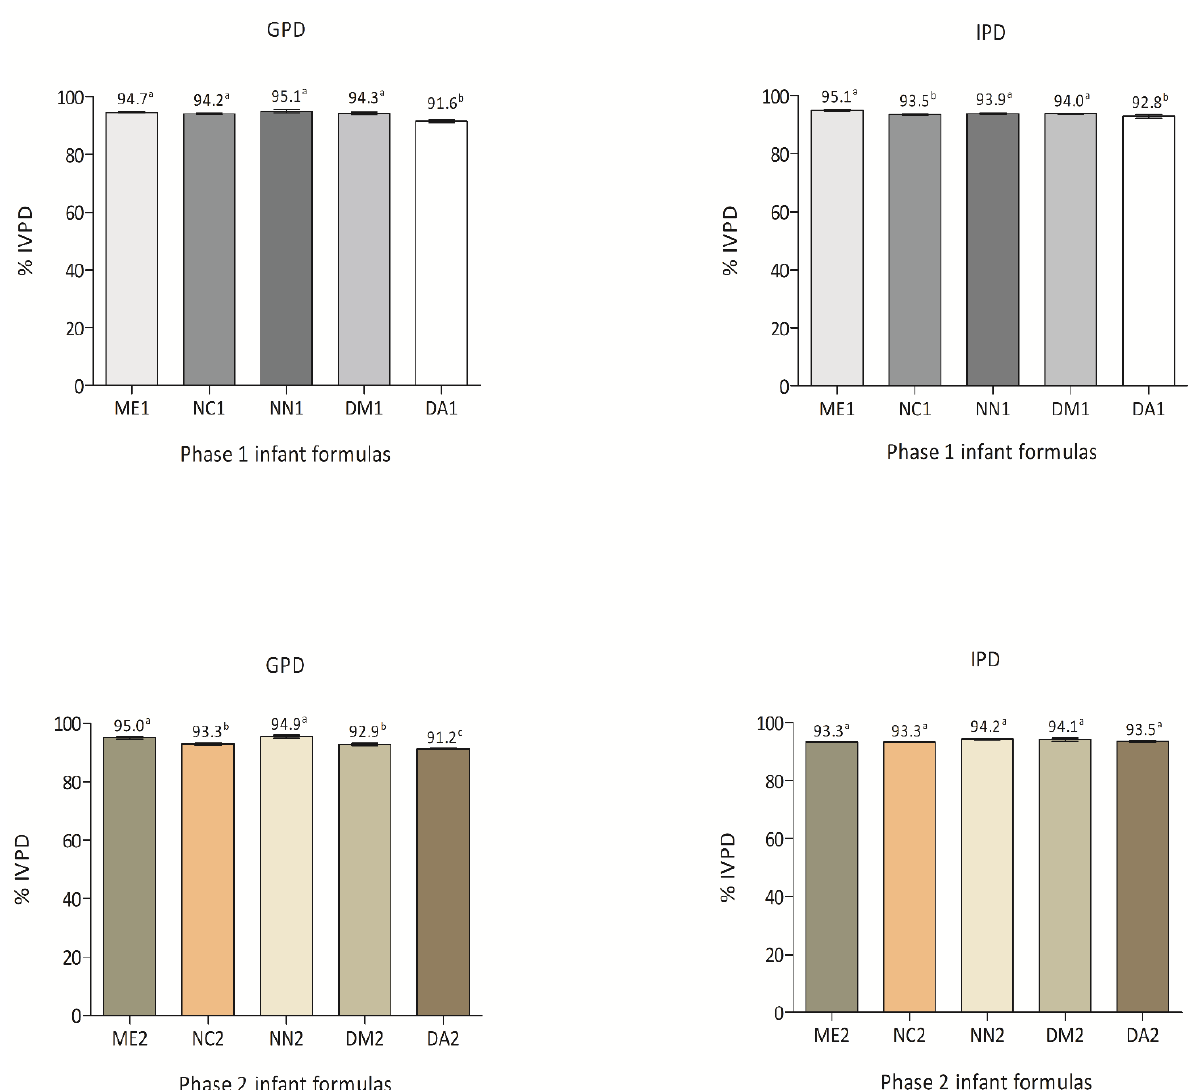
Figure 4. In vitro protein digestibility (%IVPD) of phase 1 and phase 2 infant formulas. Values are expressed as means ± SD ( n = 3). Different letters denote difference at a significance level of p < 0.05. The percentage of IVPD was estimated based on the nitrogen content by the micro-Kjeldahl method. Table 3. Average of essential amino acids contents from phase 1 and phase 2 infant formulas